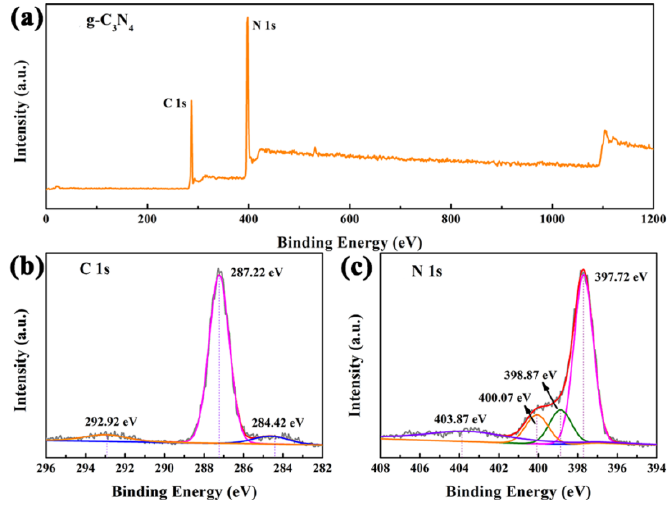
Figure 4. XPS spectra of g-C 3 N 4 sample: ( a ) survey, ( b ) C 1s, and ( c ) N 1s spectra.